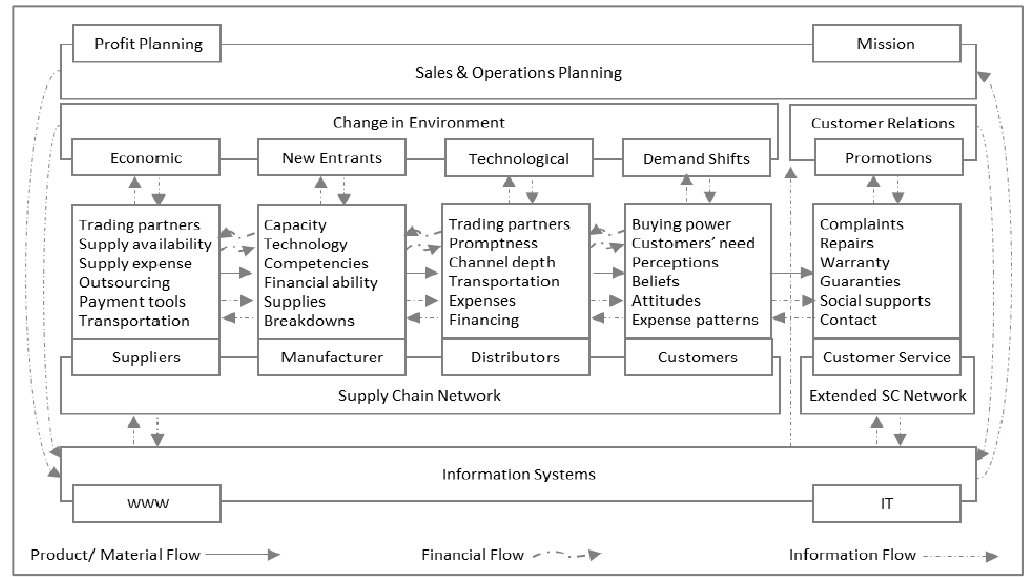
Figure 2. A Conceptual Model of S&OP and Extended Supply Chain Integration.